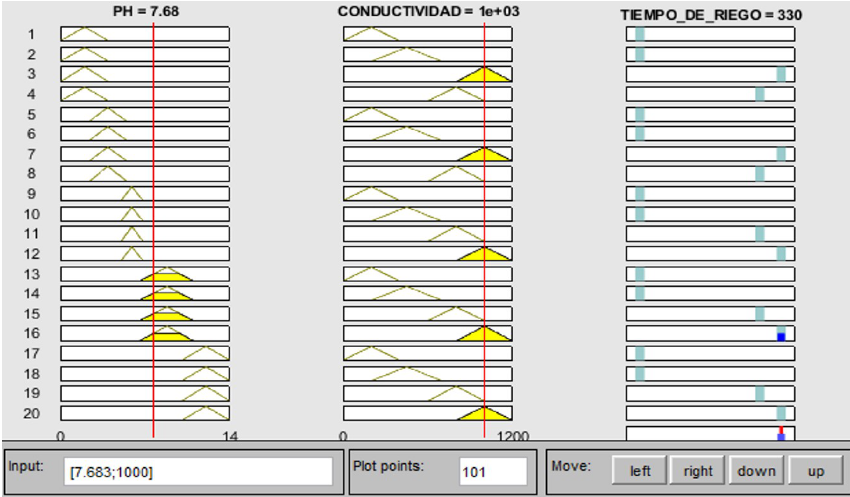
Figure 15. Fuzzy controller 2 results.